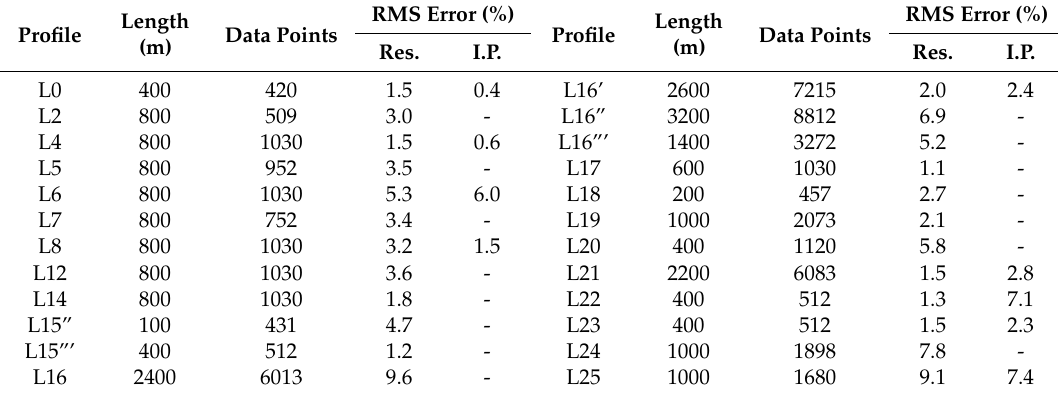
Table 1. ERT surveys with RMS error lower than 10%. Where Res. stands for resistivity and I.P. for induced polarization.